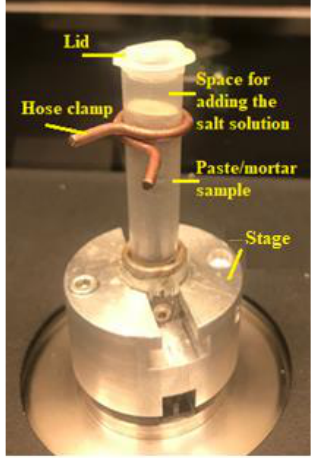
Figure 1. Sample figuration loaded in TXM machine.